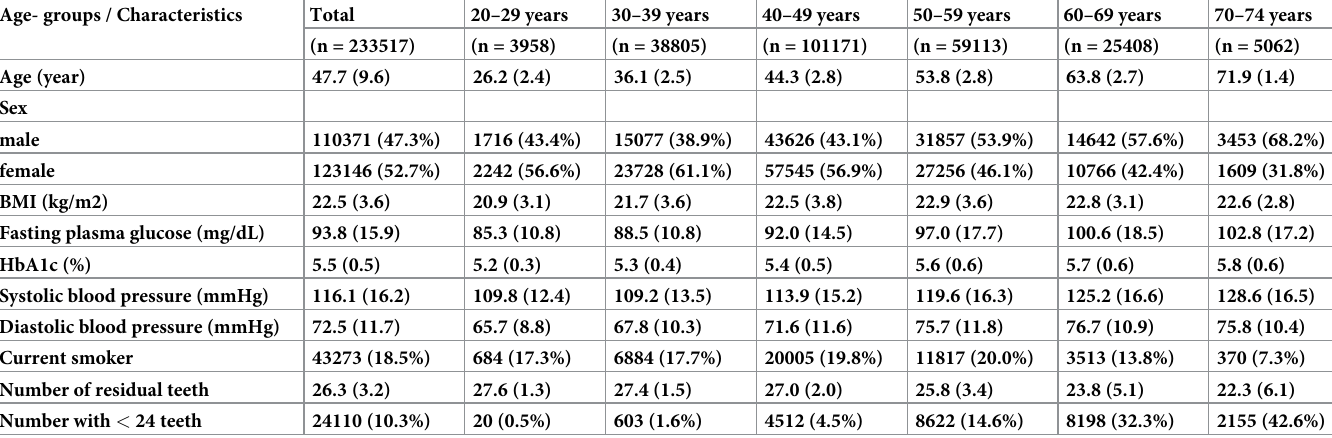
Table 1. Characteristics of the population from the medical database used in this study. BMI; body mass index. Values are means (standard deviation) or percentage. Percentages of those missing data for fasting blood glucose and systolic/diastolic blood pressures were 10.1, < 0.1, and < 0.1% respectively. Age- groups /